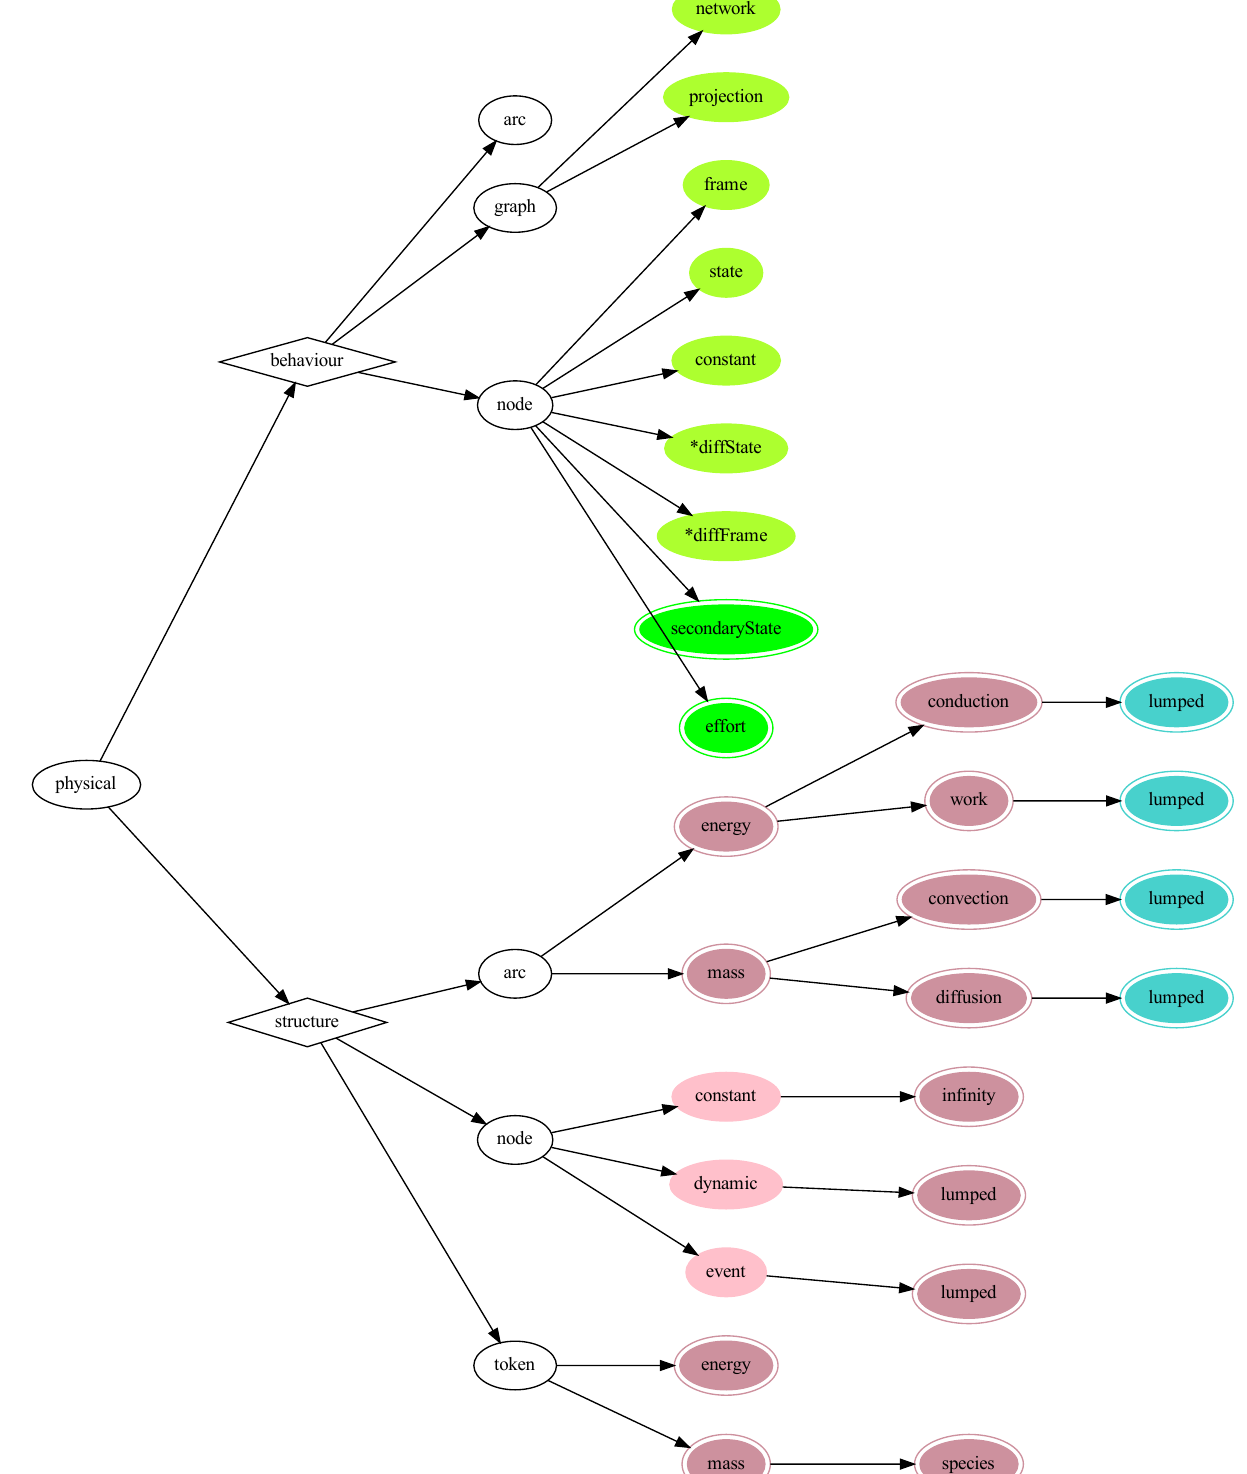
Figure 6. The physical node in the discipline tree. Both branches are expanded with additional items. In the structure branch, the basic entities are populated with tokens and specified with the modelled distribution